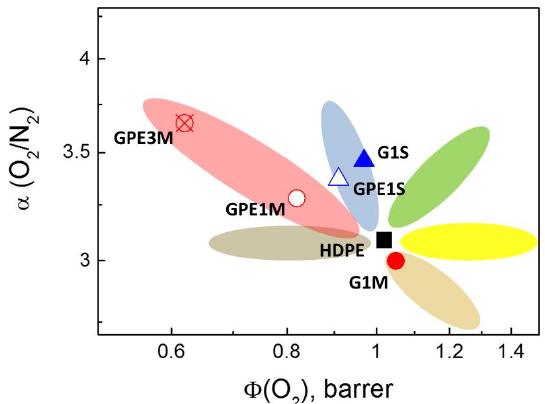
Figure 8. Representation of the relationship between composite membranes morphologies and gas transport. Symbols represent experimental data for the membranes studied in this work: ( (cid:4) ) HDPE, ( • ) G1M, ( (cid:78) ) G1S, ( (cid:52) ) GPE1S, ( ) GPE1M, and ( ⊗ ) GPE3M. (cid:35)